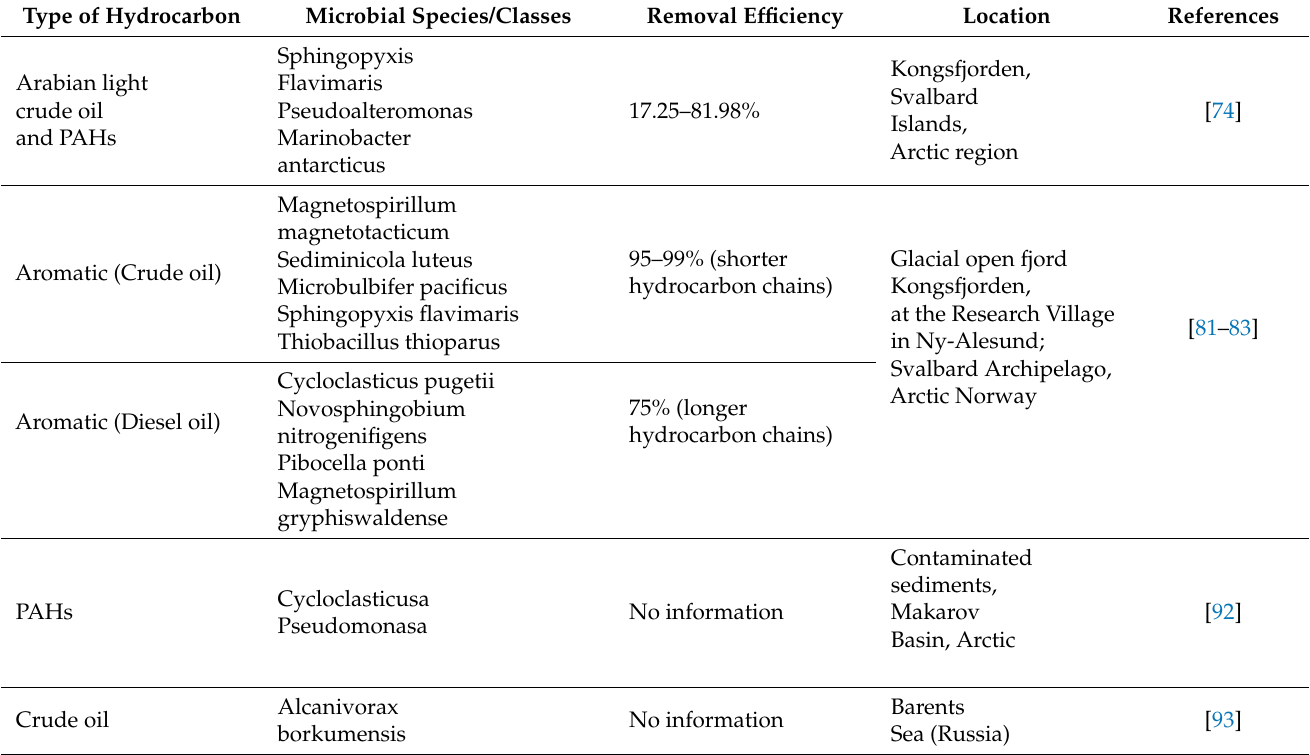
Table 7. List of hydrocarbon-degrading bacteria found in the